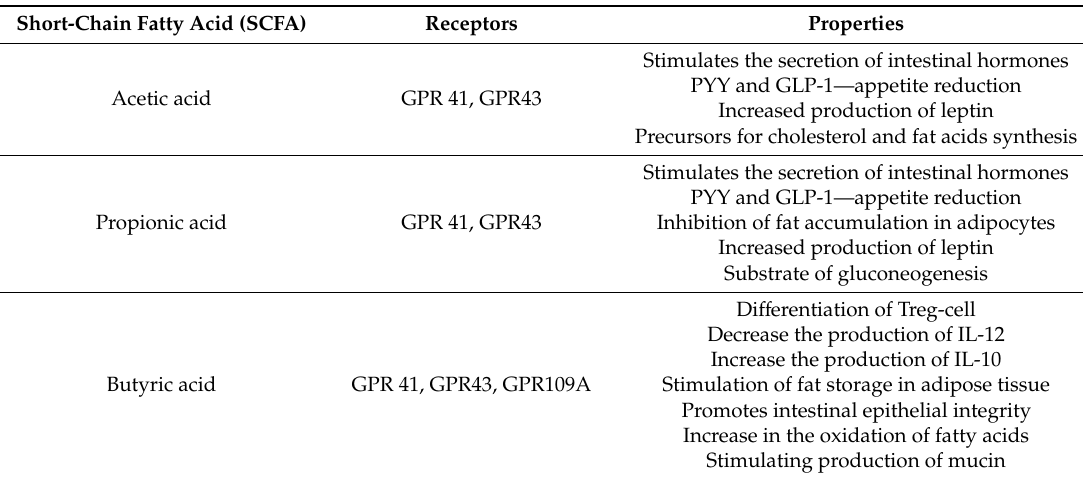
Table 1. Properties of short chain fatty acids